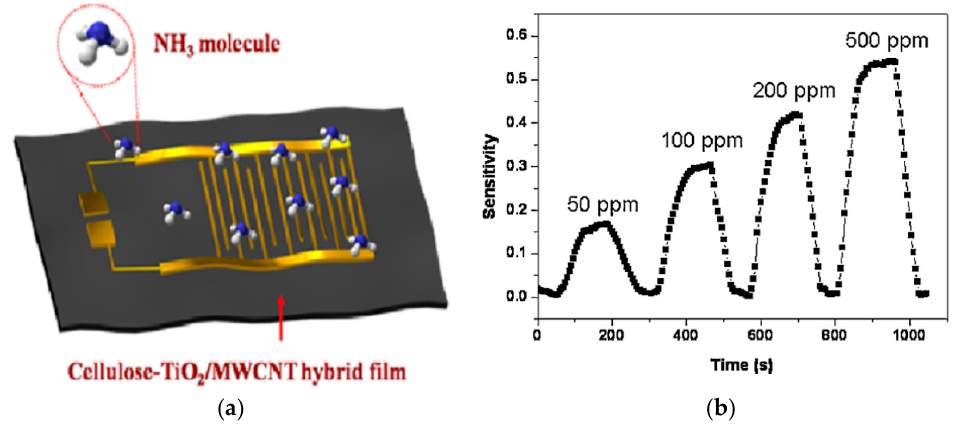
Figure 16. ( a ) Schematic diagram of NH 3 CTM sensor ( b ) Sensitivity curve